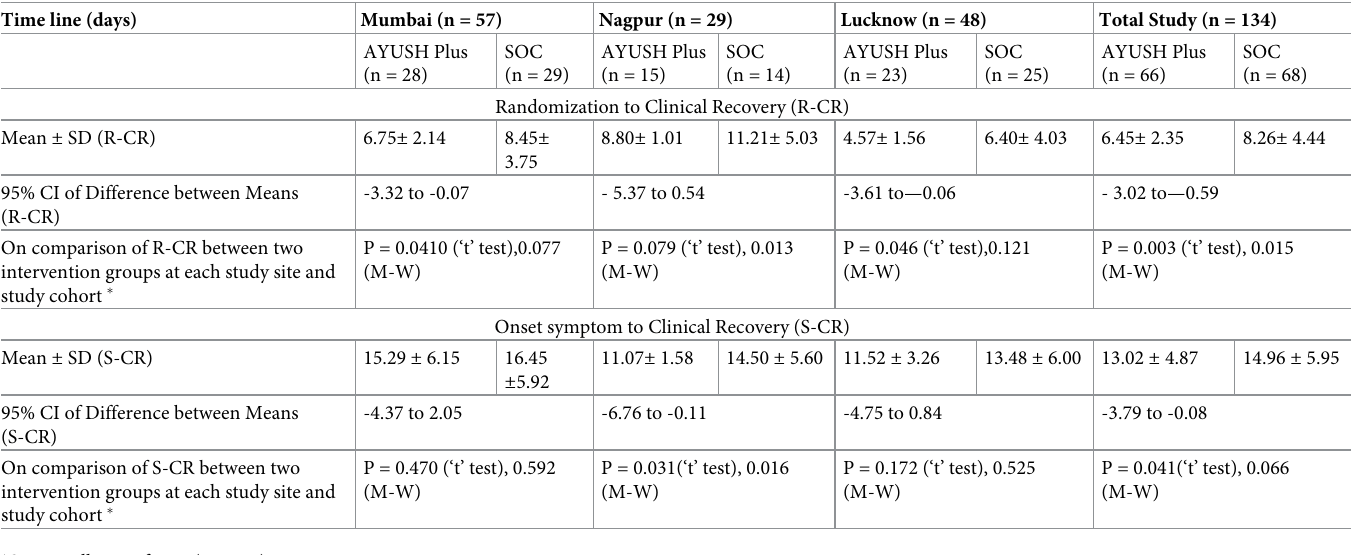
Table 2. Primary efficacy measure (Randomization to clinical recovery) and selected timeline in the two study groups (n = 134) in per protocol analysis; mean (days) ± standard deviation. Time line (days) Mumbai (n = 57) Nagpur (n =